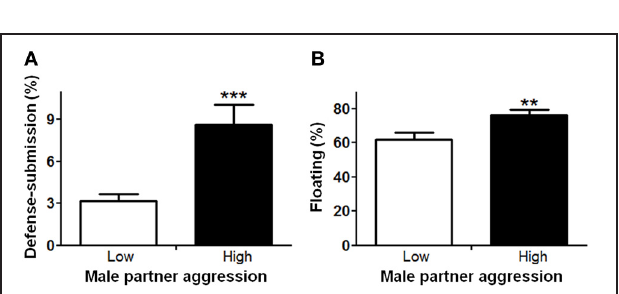
FIGURE 3 | Higher aggression by the male partner during cohabitation significantly increased (A) defensive-submissive behaviors and (B) depressive-like behavior, as determined by floating behavior. The mean ± standard error of the mean are presented. ∗∗ p < 0 . 01; ∗∗∗ p < 0 .